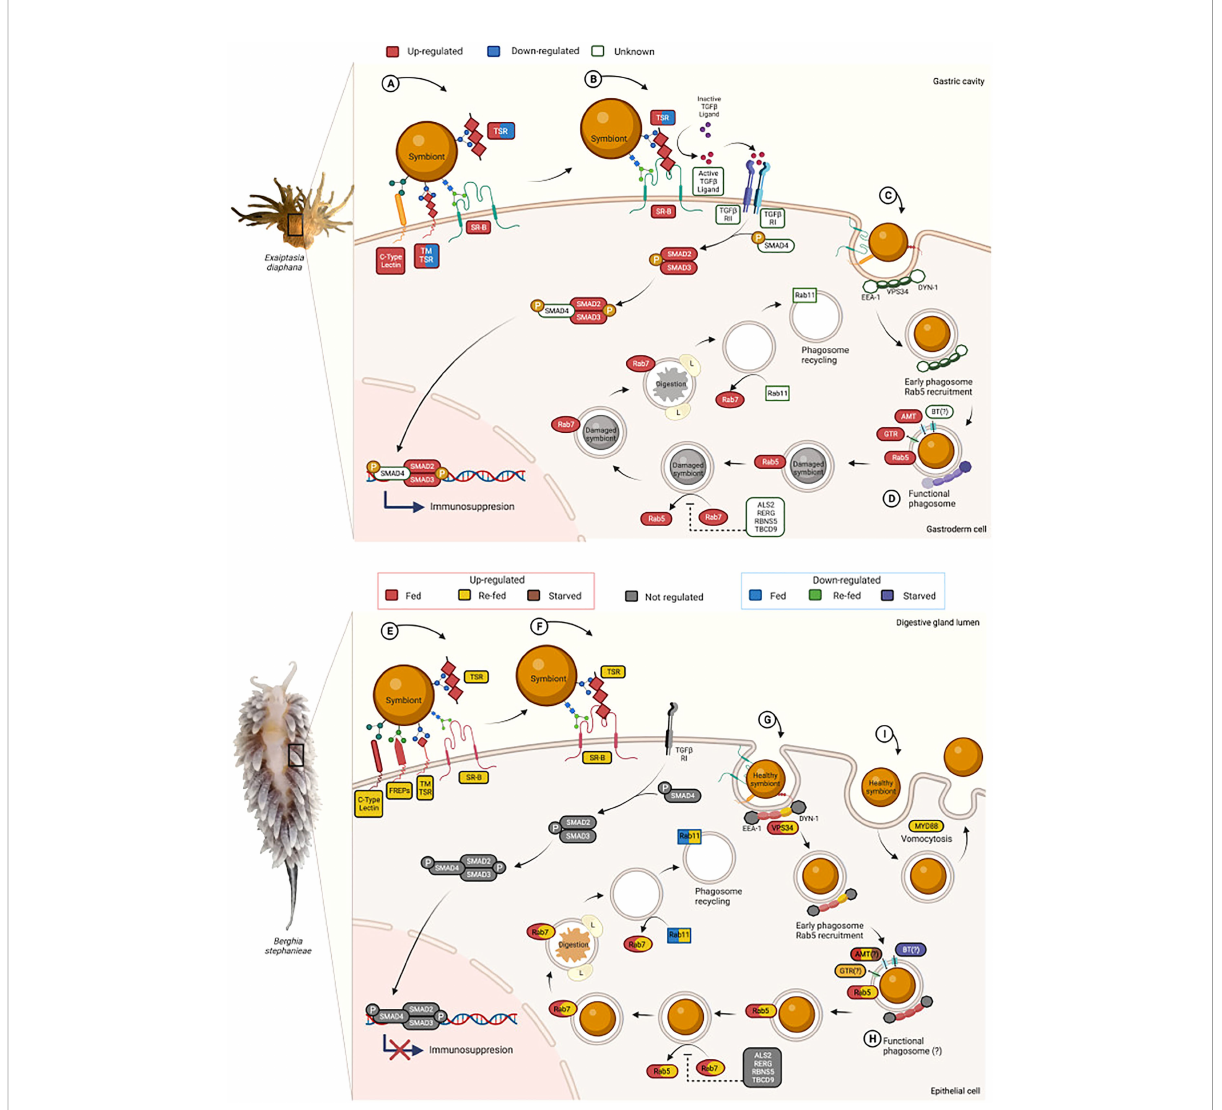
FIGURE 3 Model of the cellular events involved in the symbiont recognition and maintenance in the sea anemone Exaiptasia diaphana (A-D) based on previously published works (Chen et al., 2003, 2004, 2005, Davy et al., 2012, Detournay et al., 2012, Fransolet et al., 2012, Lehnert et al., 2014, Mohamed et al., 2016, Neubauer et al., 2016, 2017, Ishii et al., 2019) and our results on Berghia stephanieae (E-I) . In E. diaphana , the fi rst step of the winnowing is the recognition of the potential symbiont (A) mediated by the host ’ s pattern recognition receptors (PRRs) such as SR-Bs, SR- E-like, C-type Lectins, and TSRs. (B) The recognition by TSRs and/or SR-Bs seems to trigger the tolerogenic TGF- b pathway, with a high phosphorylation (P) of the transcription factor SMAD2/3 that promotes an immunosuppression response. (C) The phagocytosis of the potential symbiont takes place, where activator proteins like EEA-1, VPS34, and DYN-1 induce the early phagosome formation by the recruitment of Rab5. The phagosomal maturation continues by the replacement of Rab5 with Rab7, which induces the recruitment of lysosome-associated membrane protein (LAMP) and the fusion of the phagosome with lysosomes (L). Once the phagosome content is successfully degraded, the recyclement of the phagosome is triggered by the replacement of Rab7 with Rab11. (D) In stable symbiosis, the phagosomal maturation is inhibited and a functional symbiosome is established, where a nutrient exchange takes place via bicarbonate, glucose, and ammonium transporters, among others. In B. stephanieae , the recognition of the photobiont (E) might be mediated by PRRs such as SR-Bs, SR-E-like, C- type Lectins, TSRs, and/or FREPs. (F) The tolerogenic TGF- b pathway is not regulated, and core components like TGF- b ligand and TGF- b RII are missing. (G) During the early phagosome formation, only the activator protein VPS34 (PIK3C3) is activated and the recruitment of Rab5 is triggered. In contrast with its prey, in B. stephanieae there is no selective symbiont elimination, instead, the phagosomal maturation continues for healthy symbionts, marked by the expression of Rab7. Once the photobiont is successfully digested, the phagosome recycling is activated by the replacement of Rab7 with Rab11. (H) Since the phagosomal maturation is not inhibited, it seems that no functional symbiosome can be established or maintained, so no nutrient exchange takes place. (I) The alternative is that the photobionts cannot escape vomocytosis, given that MyD88 is activated preventing the maintenance of the photobiont in the animal host, and promoting the expulsion of healthy photosynthetically active dino fl